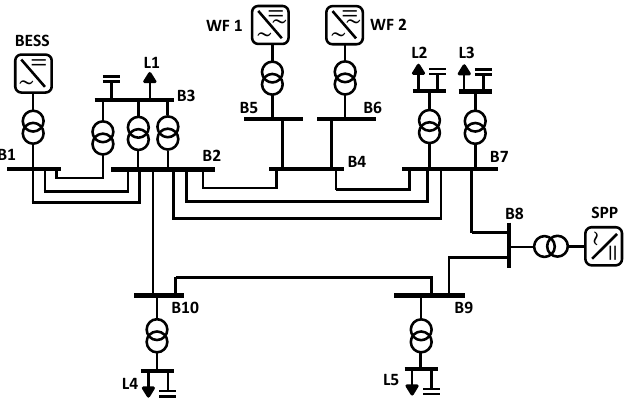
Figure 6. Single-line diagram of the studied isolated power system.